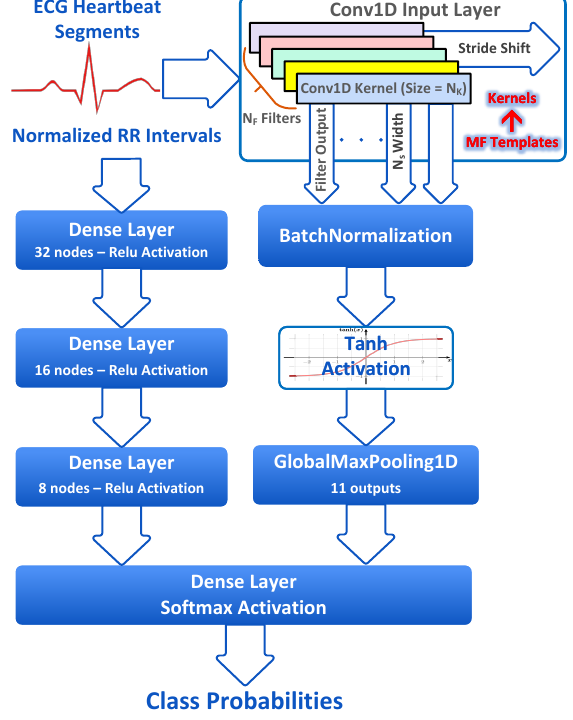
Figure 3. The match filter-based CNN ECG classifier